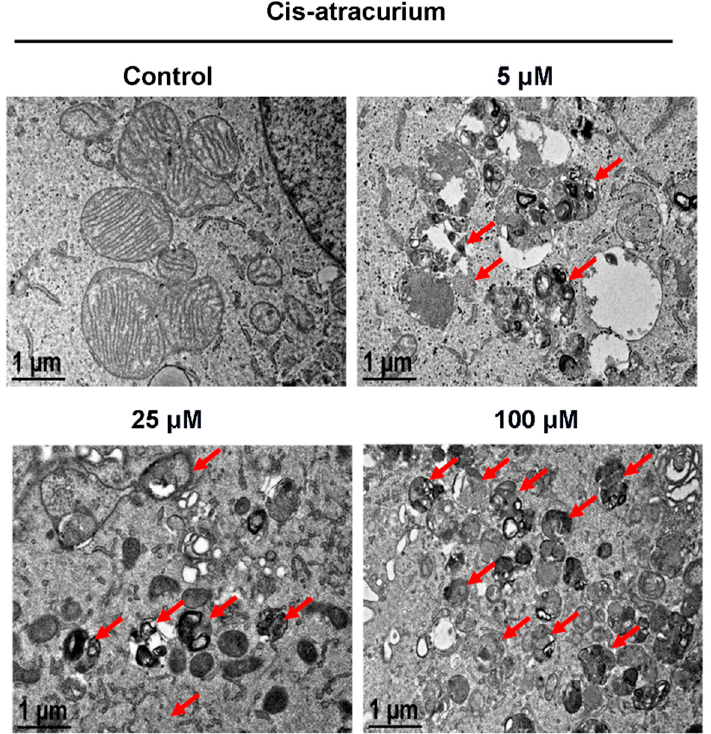
Figure 2. Cisatracurium besylate induces autolysosome formation. HUVECs were incubated with cisatracurium (0, 5, 25, or 100 µM) for 12 h. Samples were analyzed by electron microscopy. Red arrows indicate autolysosomes. The number of the autolysomes increases in a concentration dependent manner.